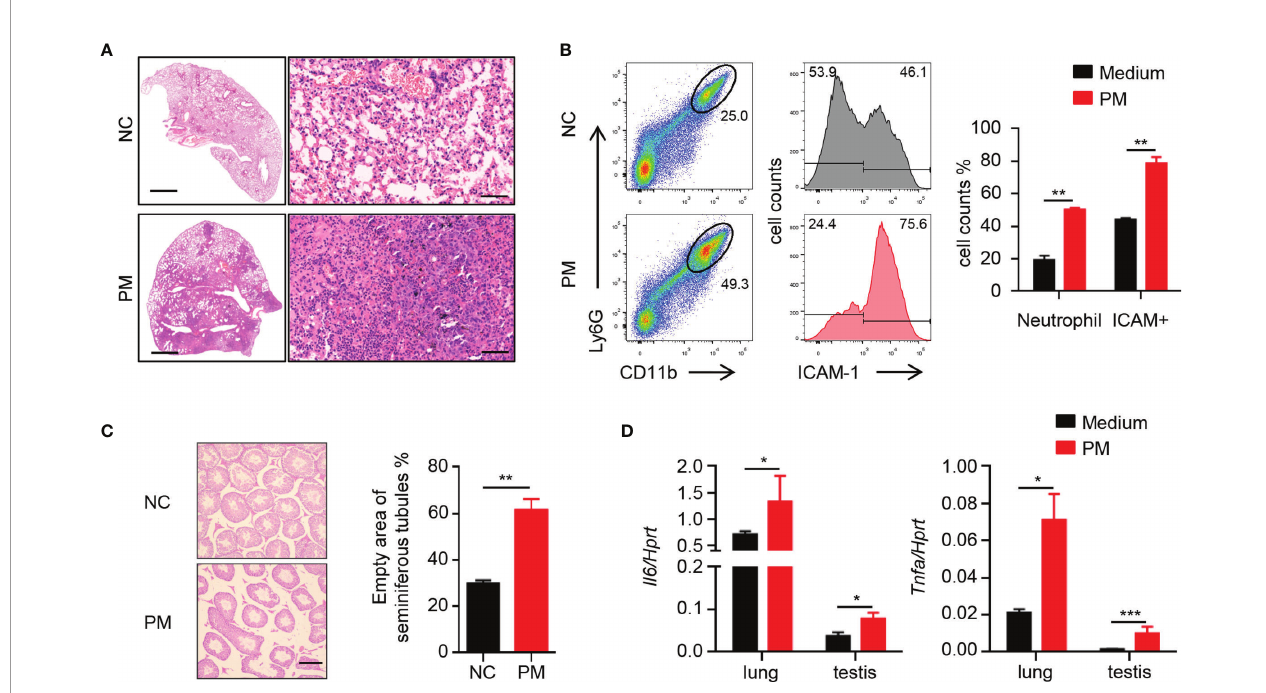
FIGURE 1 | Short-term PM exposure causes in fl ammation in lungs and testes of mice. (A) Representative H&E staining images show the in fl ammatory cell in fi ltration in lung after 7 days of PM exposure. Scale bars: 2000 m m on left, 50 m m on right. (B) FACS analysis of neutrophils and ICAM-1 + cells in lungs of mice after 7 days of PM exposure. The percentage of total cells was quanti fi ed (right). (C) H&E staining evaluation of empty area of seminiferous tubules in testes of mice after 7 days of PM exposure. The percentage of the empty area was quanti fi ed (right). Scale bars: 50 m m. (D) Expression analysis of Il6 and Tnfa in lung and testes after 7 days of PM exposure. There were 6 mice in each group. Data represent two independent experiments. Data are mean ± standard error of the mean (SEM). * P < 0.05; ** P < 0.01; *** P <